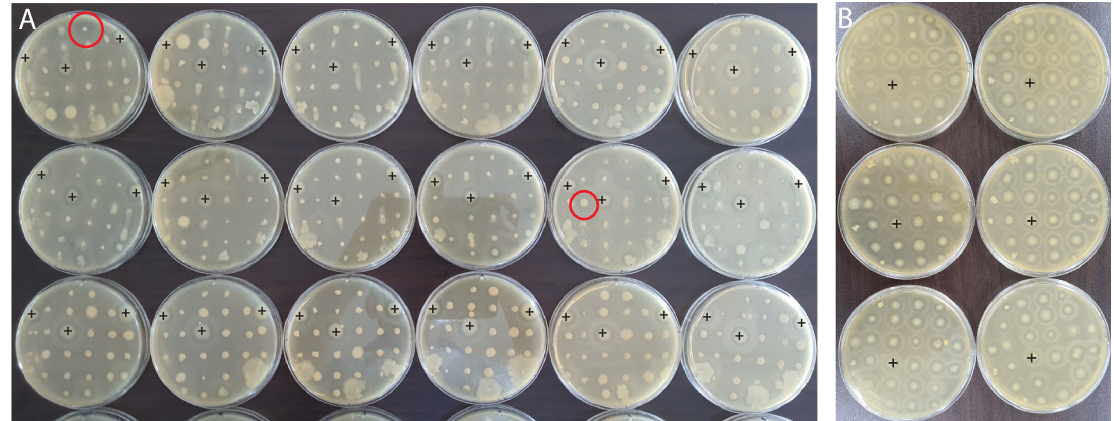
Fig 1. Initial screening of surfactin-producing bacteria. A. First round of screening: Most bacterial colonies did not produce a clear zone after oil-misting, with a few exceptions and the positive controls (+). Colored circles indicate two colonies with larger, clearer halos than the control. B. Second round of screening: Most colonies produced larger or clearer halos than the positive controls.